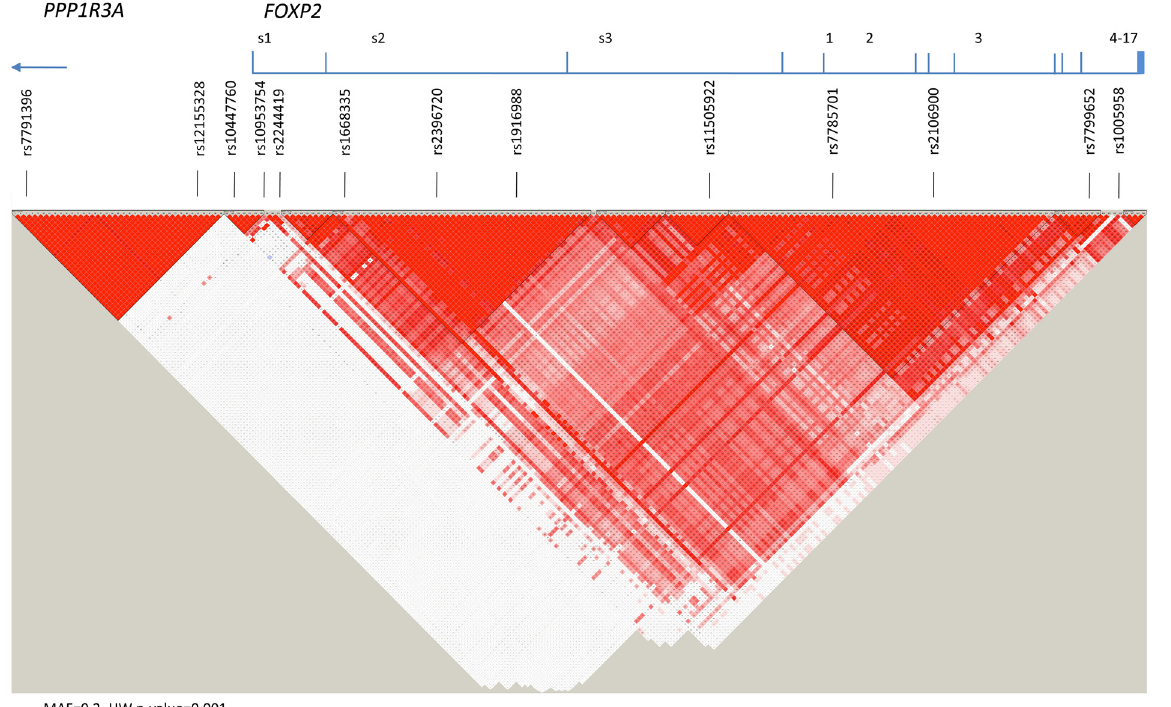
Fig 1. Linkage disequilibrium structure of FOXP2 with candidate SNPs.